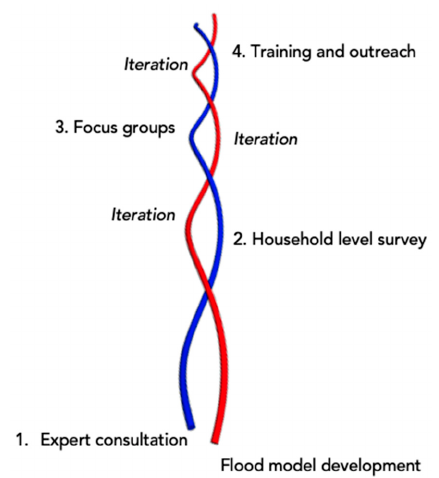
Figure 2. Collaborative modeling (CM) was developed as a four-stage process of coordinated end- user interaction and flood model development and iteration. This figure depicts an iterative process, a principle of community-based research, as identified in Israel et al.